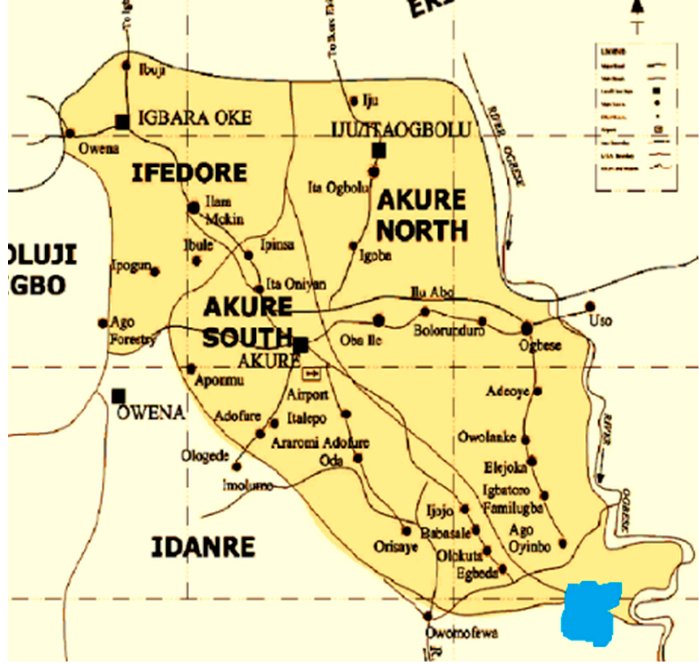
Figure 1. The political boundaries of Akure North and the location of Ala Ajagbusi (blue spot). Adapted from the work of Olamiju and Olujimi (Oluwadare and Julius 2011).